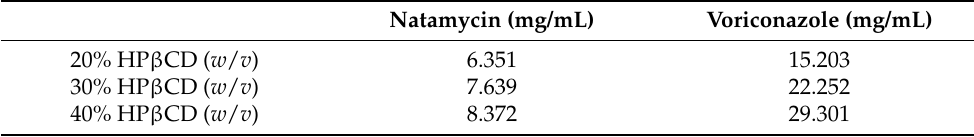
Table 5. Concentration of natamycin and voriconazole in HP β CD solutions obtained from interpola- tion in the phase diagrams (Figure 1). The HP β CD phase diagram of voriconazole was published in previous studies